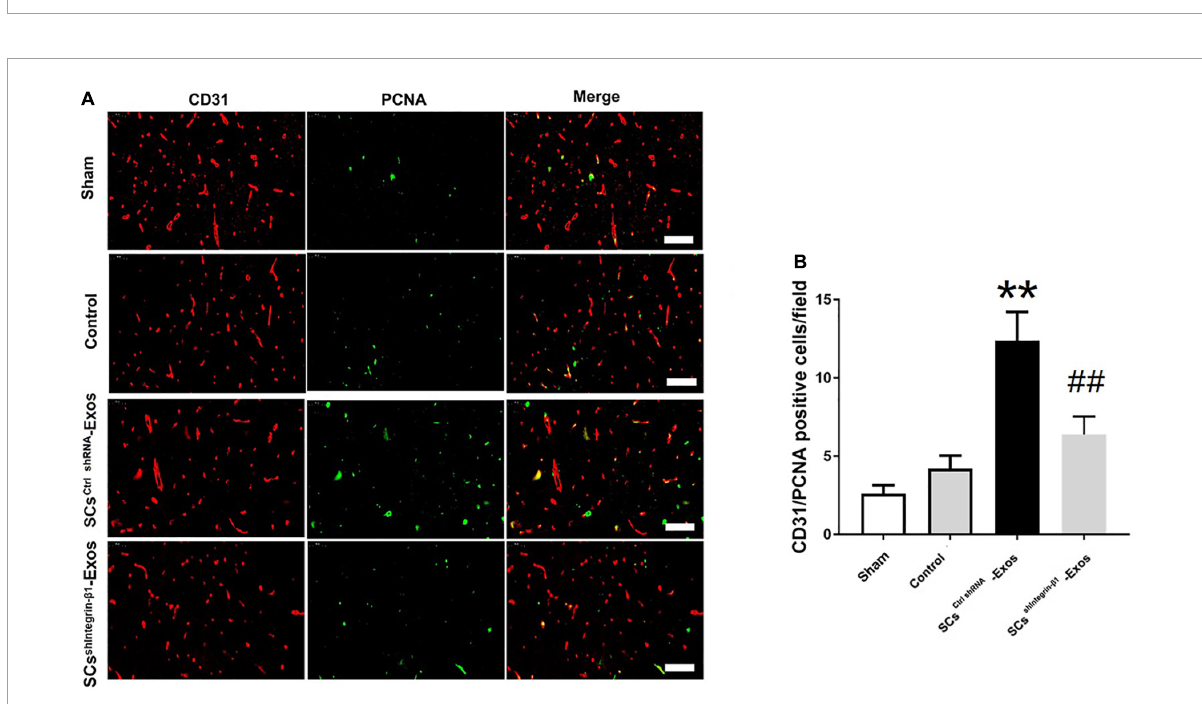
FIGURE6 Exosomal Integrin- β 1 of SCs-Exos promotes new blood vessel formation after SCI. The presence of proliferation of blood vessels in the spinal cord on day seven after SCI was analyzed by immunofluorescence staining. (A) Representative image of CD31-positive (Red) and PCNA-positive (Green) cells in the anterior horn of the spinal cord from each group at 7 days post-injury. (B) Quantitative analysis of CD31/PCNA-positive cells in the injured spinal cords from each group. The data are presented as mean ± SD. ** p < 0.01 Control group vs. SCs ctrlshRNA -Exos group, ## p < 0.01 SCs ctrlshRNA -Exos group vs. SCs shIntegrin − β 1 -Exos group. N = 5 in each group. Bar = 50 µ